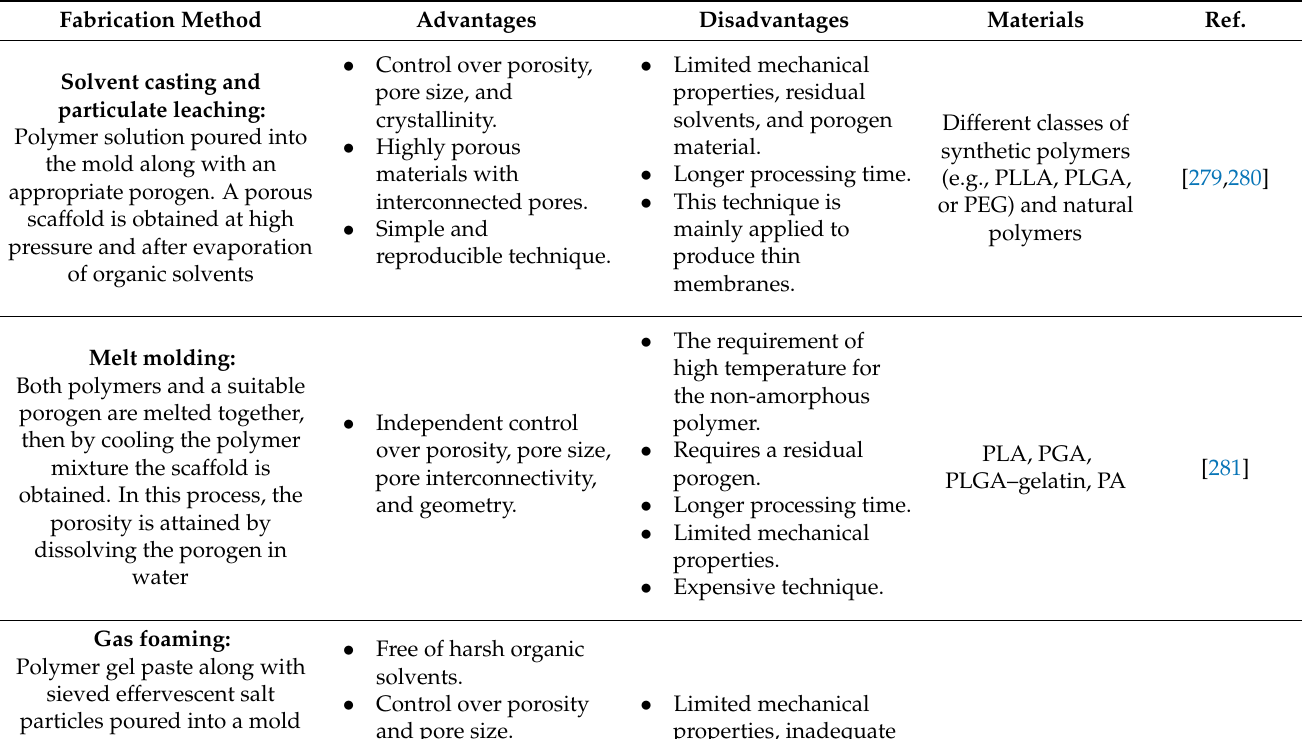
Table 8. Biopolymer scaffold fabrication